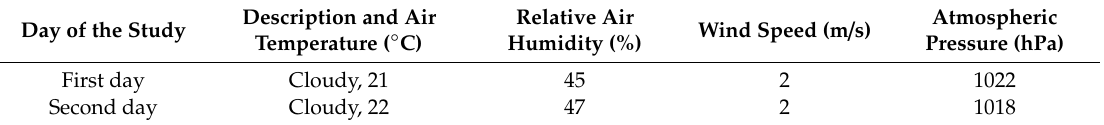
Table 2. Weather conditions during the